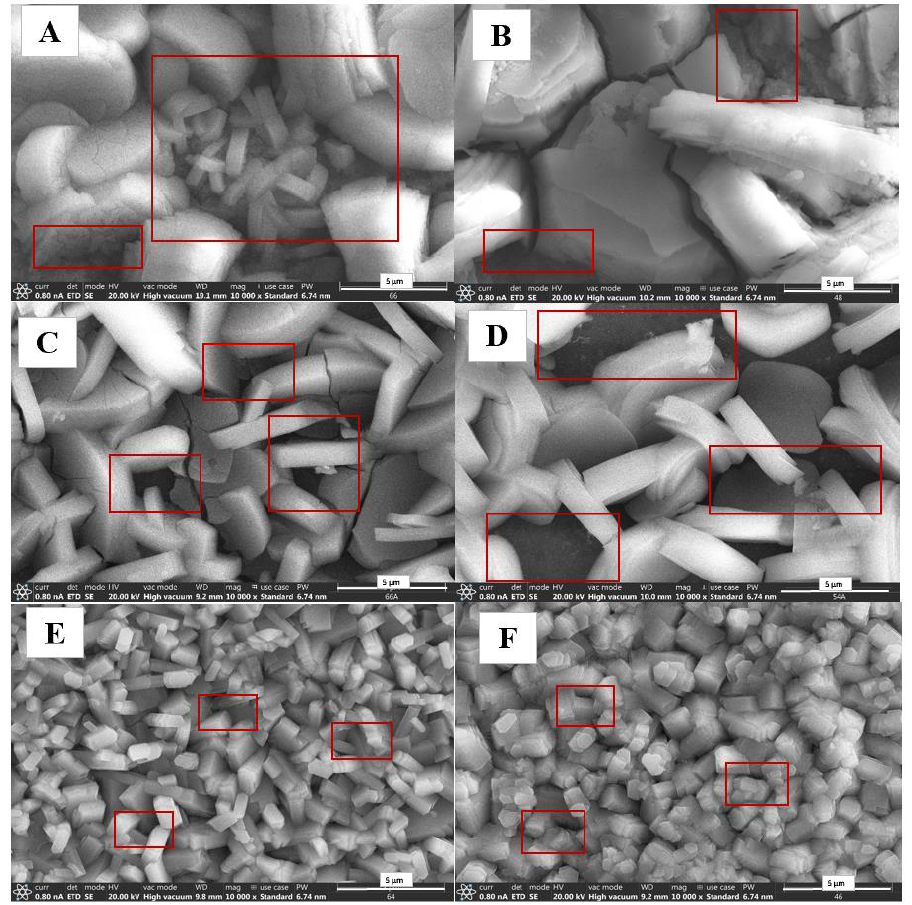
Figure 7. SEM images of the phosphate coatings: AL1-N ( A ), AL1-NG ( B ), AL2-N ( C ), AL2-NG ( D ), ST-N ( E ), ST-NG ( F ). The parts marked with a red square show the gaps.